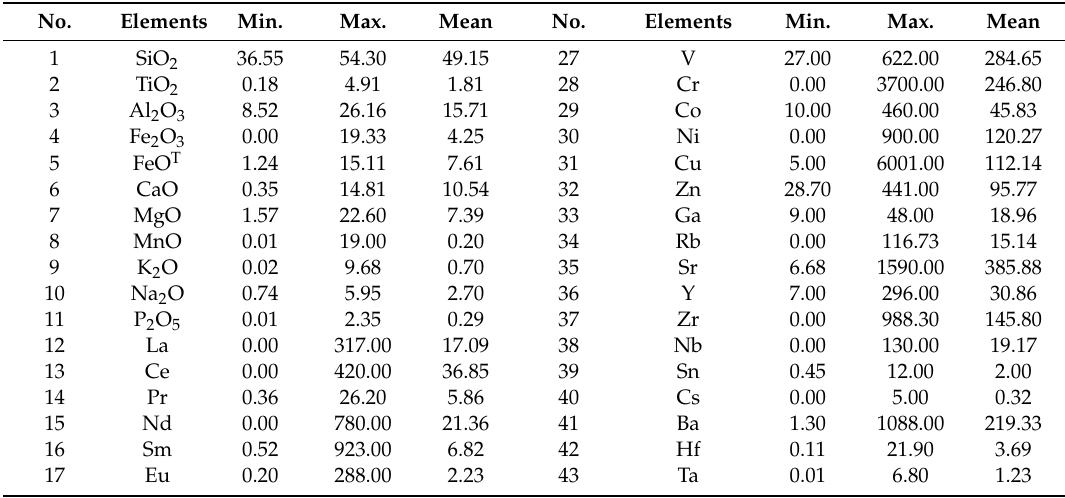
Figure 4. Global distribution map of basalt sample collection sites. Table 2. Basic statistics for dataset 1 with high-dimensional features.